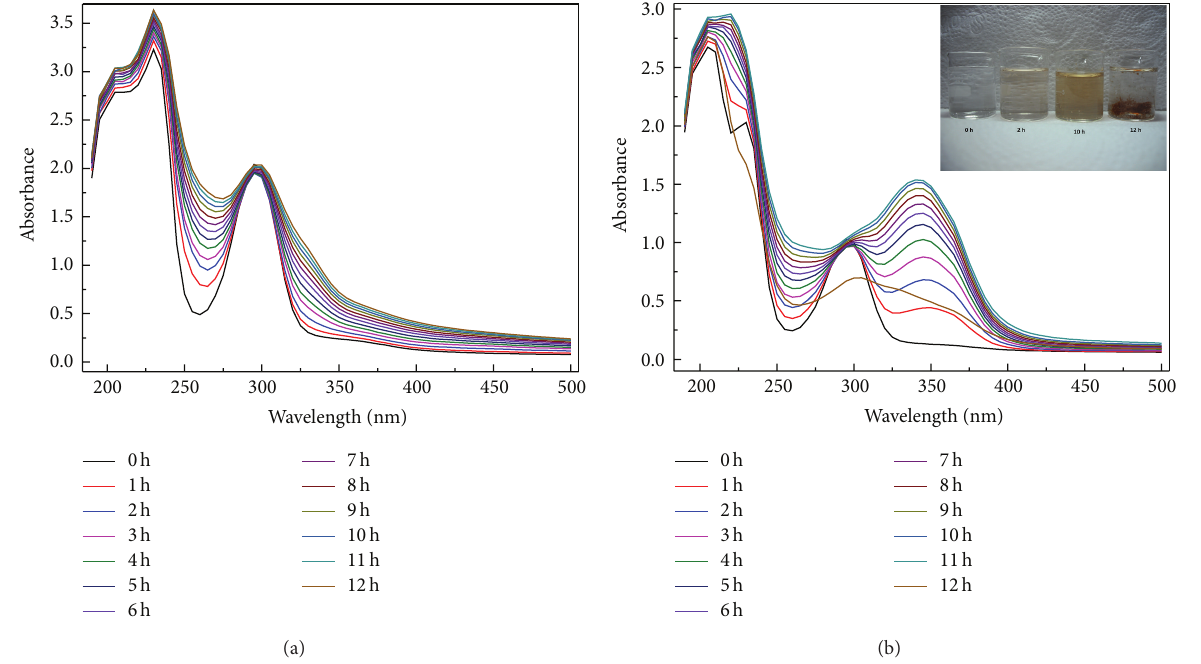
Figure 4: UV-Vis spectra for solutions of (a) pure SA and (b) SA + PAH at different irradiation times (0–12h). Measurements performed at pH 9 and 25 ∘ C. The inset shows the image of the as-prepared SA + PAH solutions (0 h) and after UV-B irradiation (2, 10, and 12h) at 25 ∘ C, pH 10.